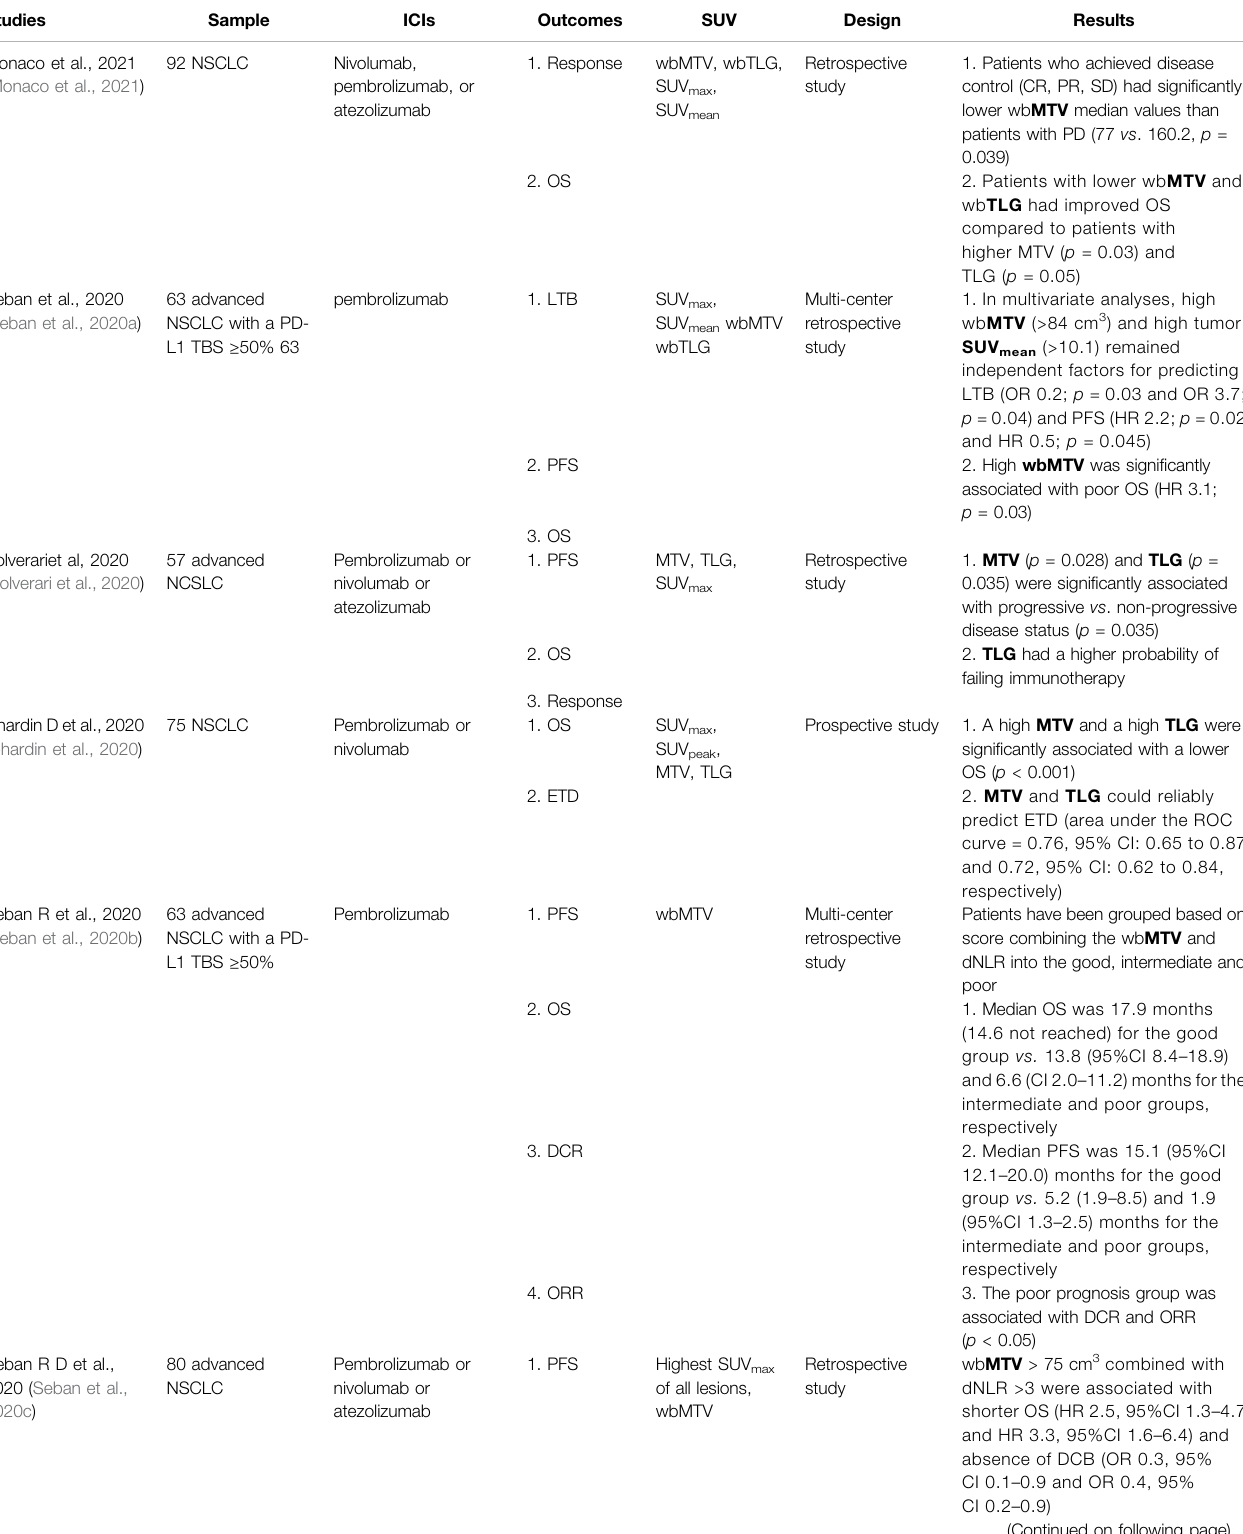
TABLE 2 | The studies on the predictive value of semi-quantitative parameters for immunotherapy in NSCLC patients.